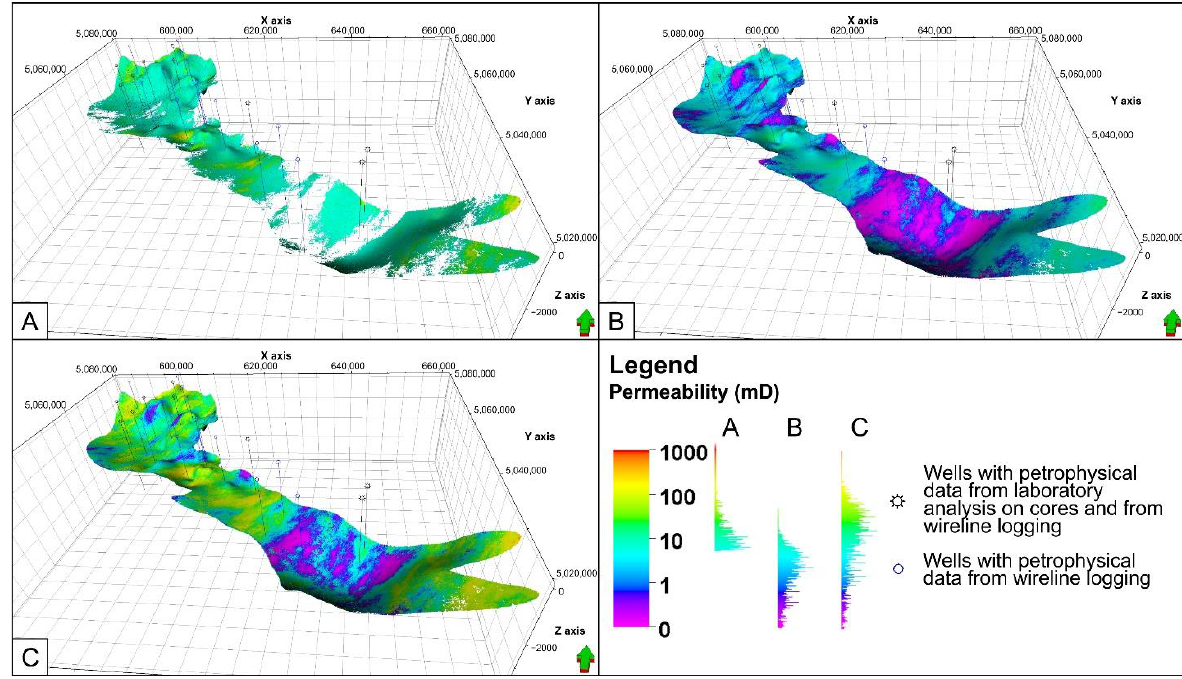
Figure 6. Spatial distribution of the porosity within the DSA Poljana with a frequency plot.